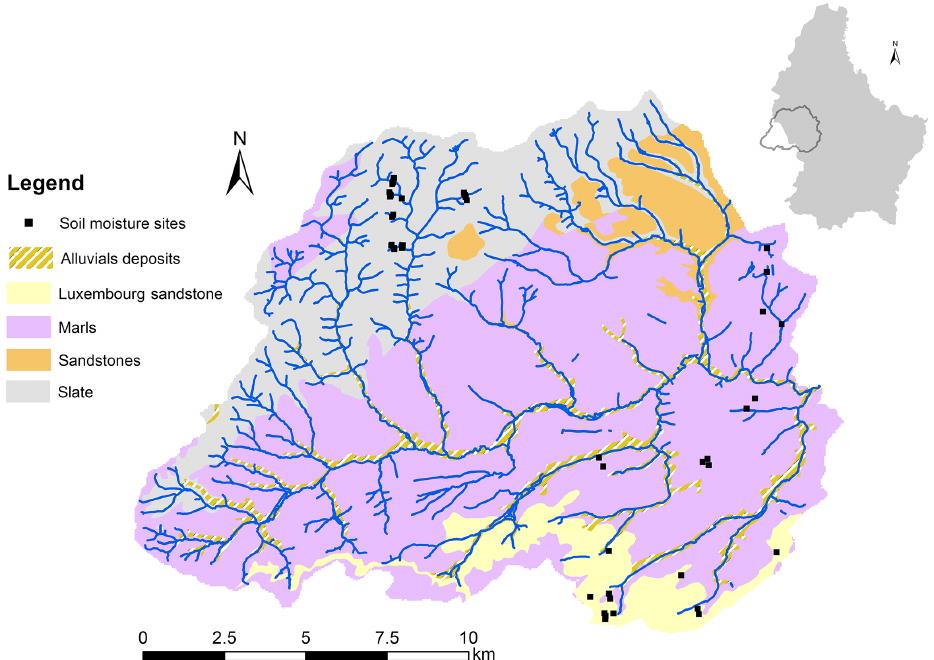
Figure 1. Map of the Attert catchment in Luxembourg with the three main geologies and the locations of the 45 soil moisture monitoring sites. Table 1. Site information of the six defined landscape units. Additional textural information can be found in the Supplement (Table S1). Texture denoted with ∗ was estimated with a field test by feel. Date format is mm/yyyy. Slate Marl Sandstone Forest Grassland Forest Grassland Forest Grassland 45 21 15 18